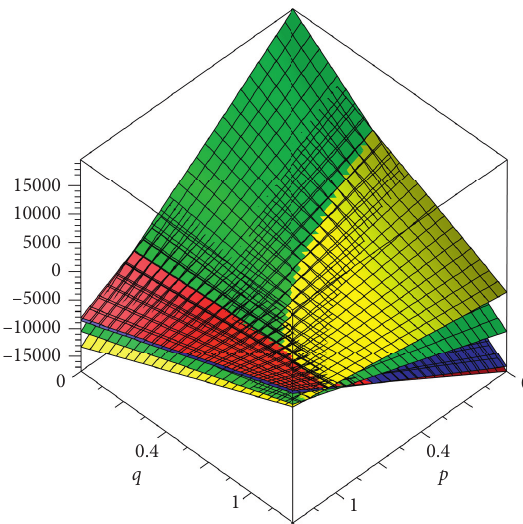
Figure 20: Comparison of the second hyper-Gourava index.